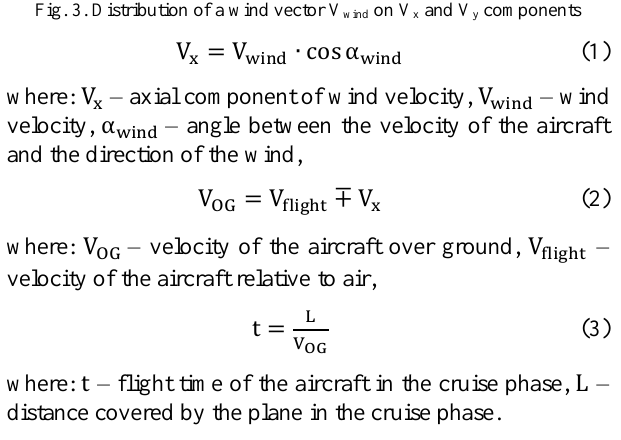
Fig. 3. Distribution of a wind vector V wind on V x and V y components